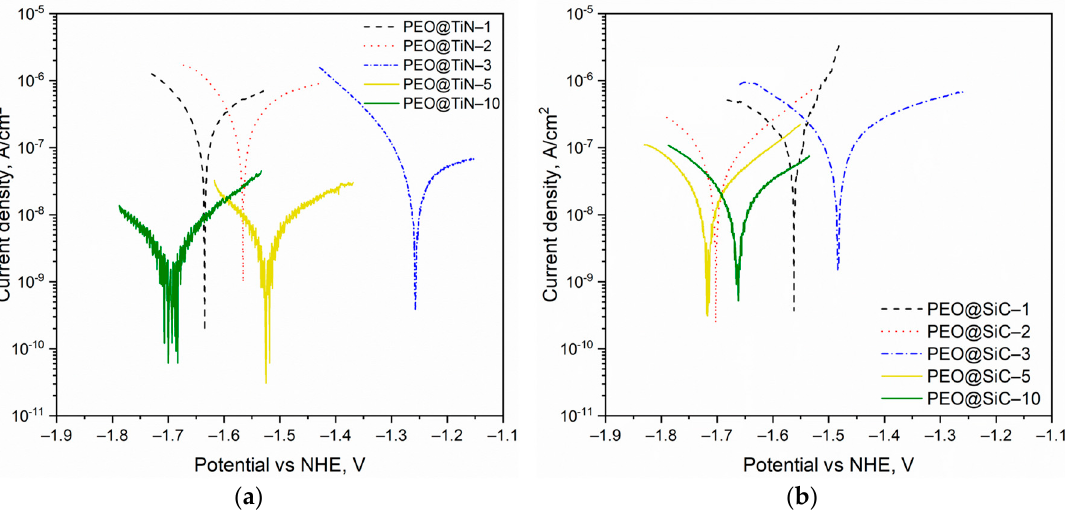
Figure 6. Tafel curves from potentiodynamic polarization testing of the PEO coatings containing nanoparticles of ( a ) TiN and ( b ) SiC. Table 2. Results of PDP test on samples with various PEO